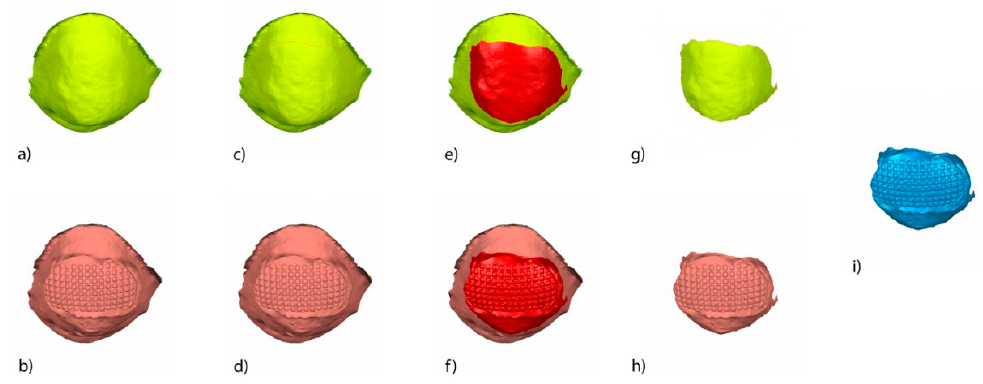
Figure 9. Palatal perspective of the tooth 1.5 segmented on STL1 ( a ), solid mesh of tooth 1.5 on STL2 with the volume of the cement used to adhere and the absence of a bracket. ( b ) Slight over-contouring of STL1 ( c ) and the mesh of STL2 without a bracket. ( d ) Boundary of the orthodontic cement used to fix the corresponding lingual bracket appliance of STL1 ( e ) and the mesh of STL2 without a bracket. ( f ) Mesh of the orthodontic cement used to fix the corresponding lingual bracket appliance on STL1 ( g ) and the mesh of STL2 ( h ) and combined meshes with the orthodontic cement used to fix the corresponding lingual bracket appliance, obtaining a closed polygon ( i ).